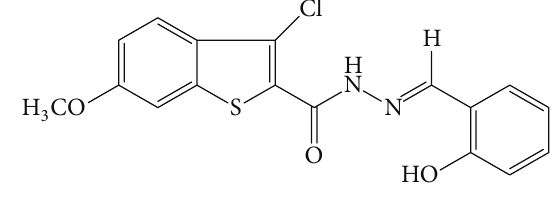
Figure 9: Schiff base